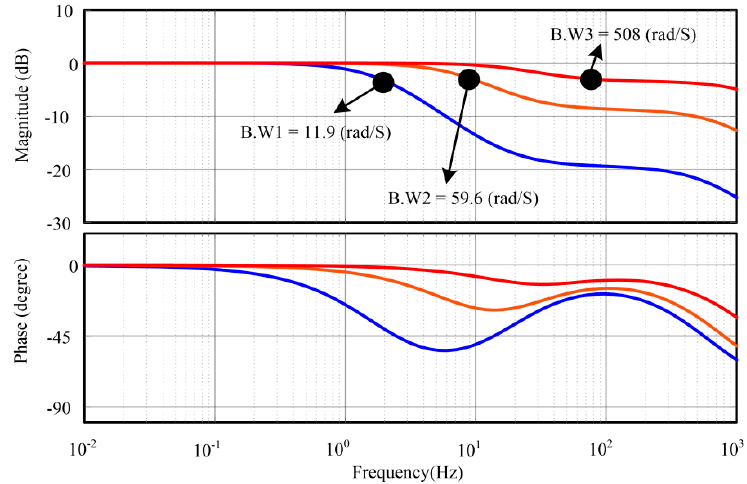
Figure 12. The closed-loop frequency response of Lead/Lag PLL.